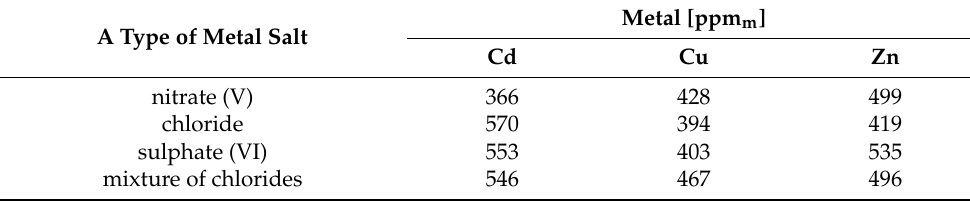
Table 1. Initial concentrations of metals in samples of nitrates (V), chlorides, sulphates (VI) and in a mixture of